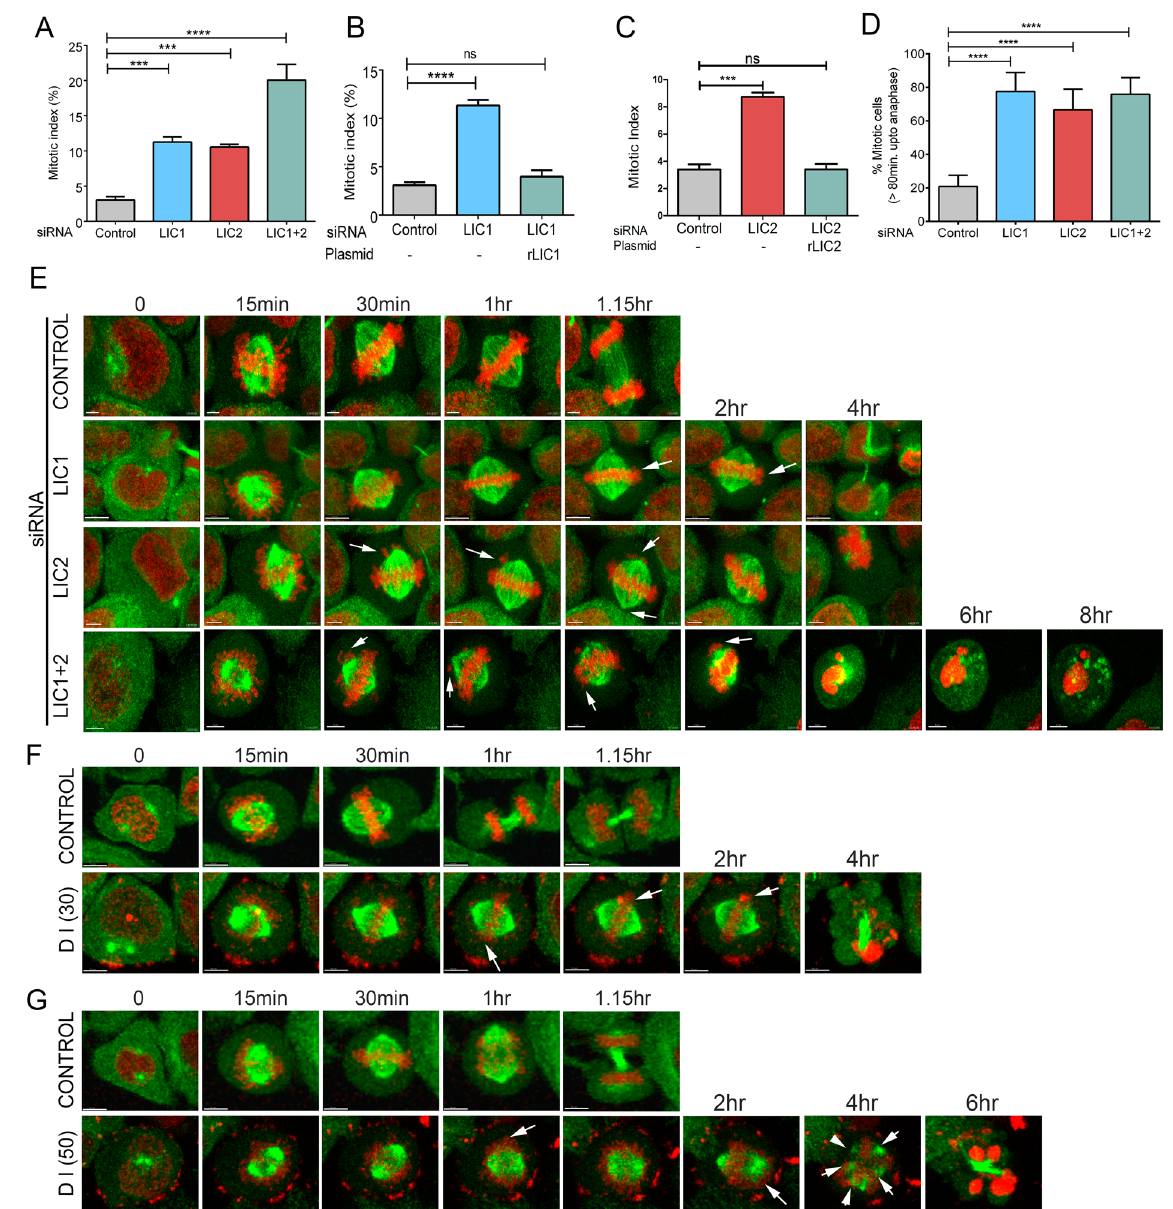
Figure 1. LIC2 is required for mitotic progression in HeLa cells. ( A ) Mitotic index in HeLa cells (y-axis); the % of total cells present in metaphase + / − SD. (3 experiments, n = approximately 500 cells per experiment). ( B , C ) Rescue of the metaphase arrest by transgenic expression of rat LIC1 ( B ) and rat LIC2 ( C ) (3 experiments, n = at least 500 cells per experiment). ( D ) Fraction of mitotic cells from G that spent > 80 minutes in mitosis. p values in all panels are * p < 0.05, ** p < 0.01, *** p < 0.001. ( E ) Still images from movies featuring different siRNA treated HeLa cells expressing H2B-mCherry and GFP- α -tubulin (control, LIC1, LIC2 and LIC 1 + 2 depleted) showing prolonged arrest in mitosis. Time points indicate time after nuclear envelope breakdown. ( F ) Still images from movies representing effect of dynein inhibitor ciliobrevin (DI) at different concentrations 30 μ M ( F ) and 50 μ M ( G ) with DMSO as